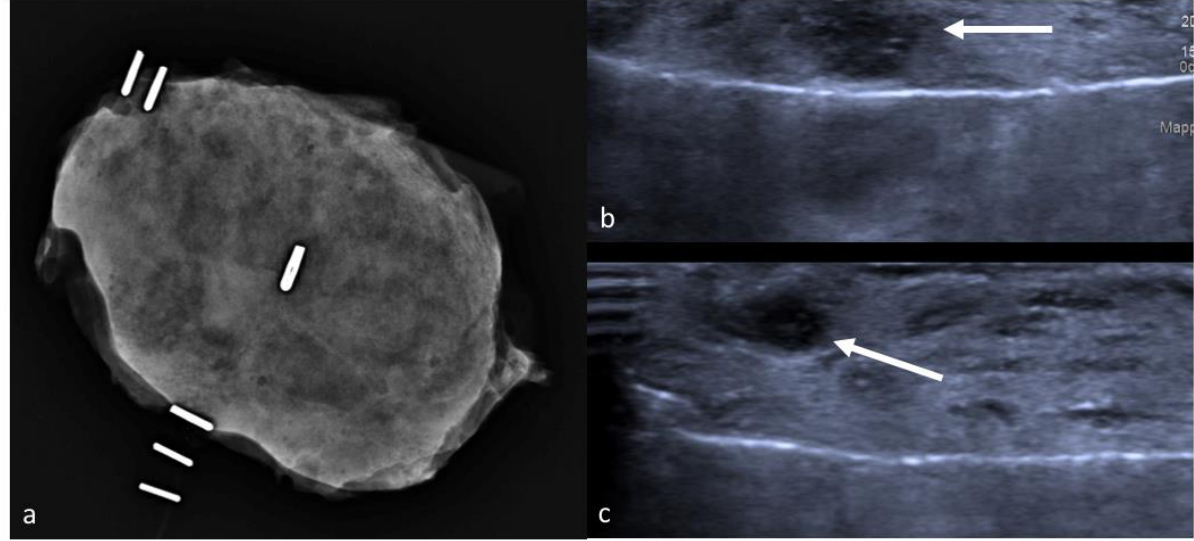
Figure 6. Radiograph of a dense, glandular specimen with scarcely recognizable nodules ( a ). Subsequent specimen ultrasound demonstrates successful removal of two masses (arrows) ( b , c ).